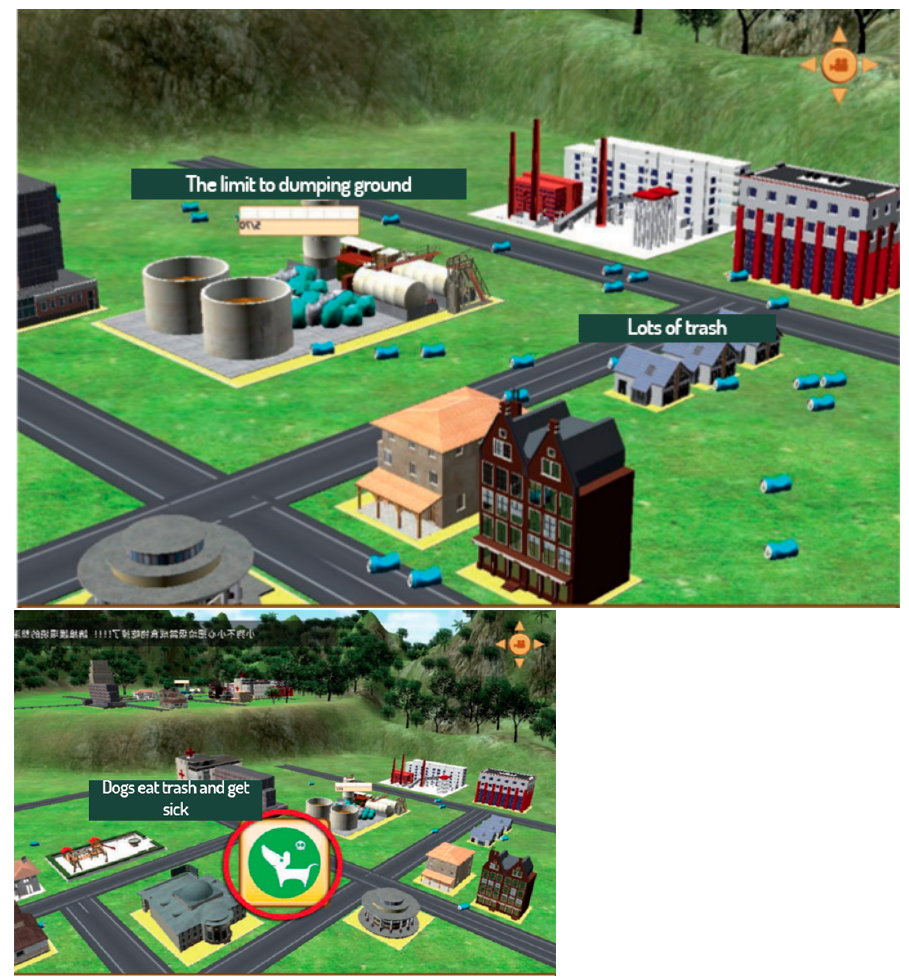
Figure 3. Wu and Huang’s Waste Management Simulation Game evaluated two groups’ planning decisions with respect to economic and environmental impact (Adapted with permission from Ref.